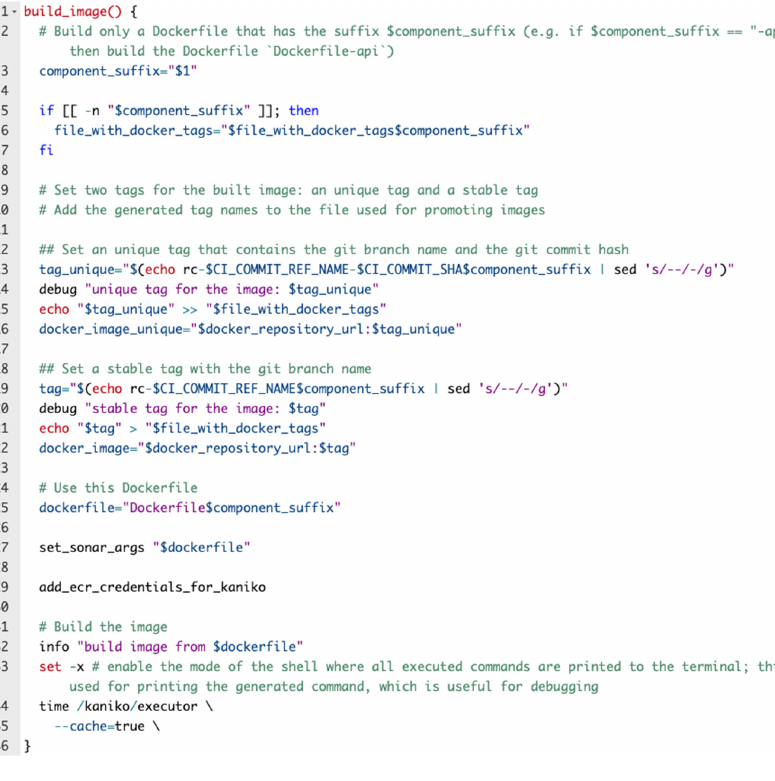
Figure 8. Build image function. Sensors 2022 , 22 , x FOR PEER REVIEW